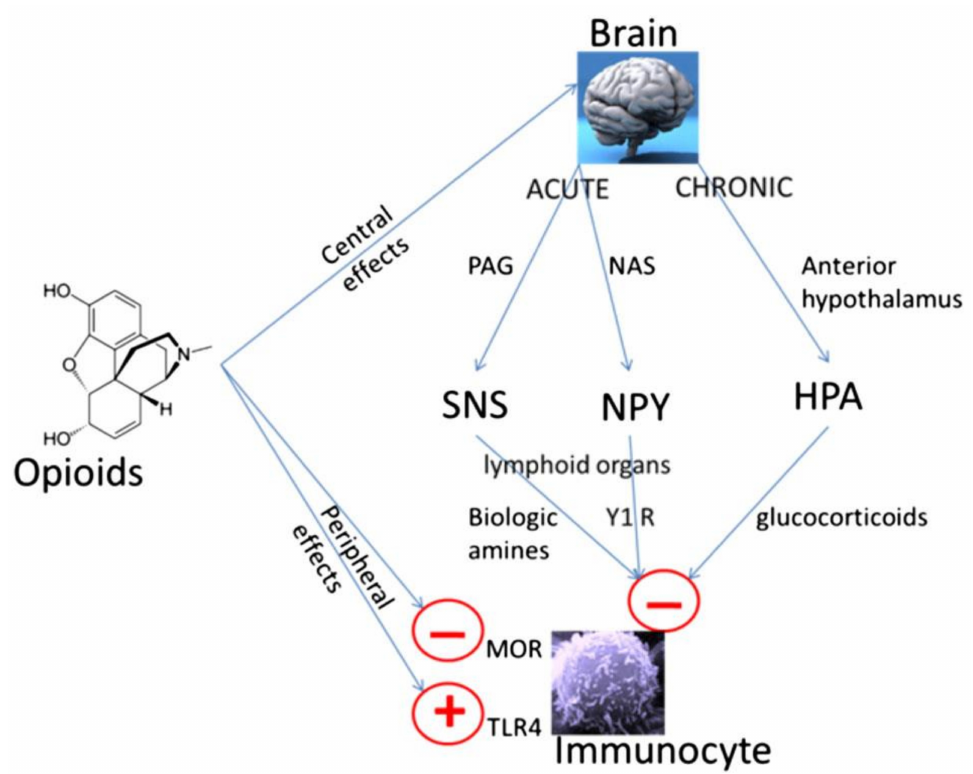
Figure 1. Peripheral and central mechanisms of opioid-induced immune suppression. Opioids can have direct effects on immune cells which express appropriate receptors such as the mu opioid receptor (MOR) and Toll-like receptor-4 (TLR-4); although there are differences between opioids [6,21,23,24]. Opioids can also have centrally mediated immunosuppressive effects [26,27]. Immediate central effects of opioids include enhancement of periaqueductal gray (PAG) activity. This in turn causes activation of the sympathetic nervous system (SNS). By innervating lymphoid organs, activation of the SNS leads to the release of biological amines which decreases cytotoxic- ity of NK cells and splenic lymphocyte proliferation [26]. In rodent models, morphine has acute effects via D1 dopamine receptors in the nucleus accumbens shell, which leads to an increase in the release of neuropeptide Y (NPY), this then reduces splenic NK cell cytotoxicity [27]. Chronic opioid administration increases activity in the hypothalamic pituitary adrenal (HPA) axis leading to glucocorticoid production, decreasing cytotoxicity of NK cells [26]. Reproduced with permission